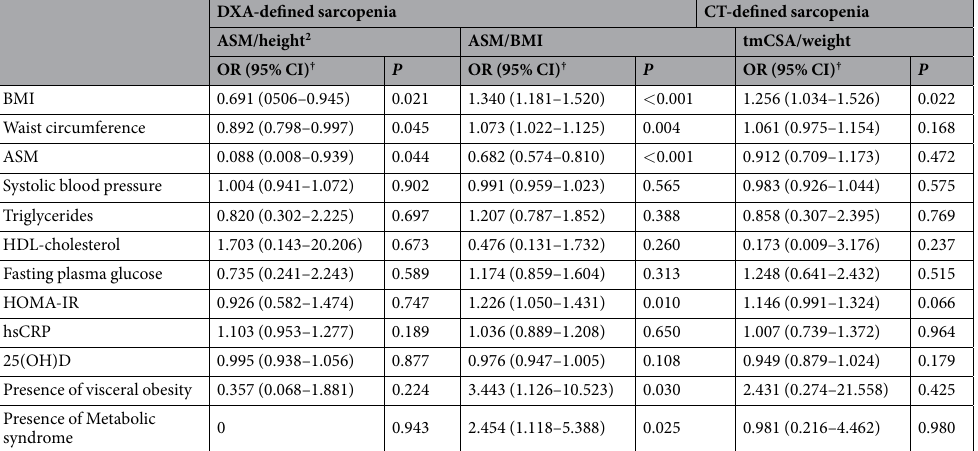
Table 3. Logistic analysis to evaluate relationships between sarcopenia defined by DXA or CT and clinical, metabolic, and body composition variables including presence of visceral obesity and metabolic syndrome. CI, confidence interval; OR, odds ratio. † Each of the independent variables is included in the logistic regression model after adjusting for age, gender, current smoking, alcohol consumption, and physical